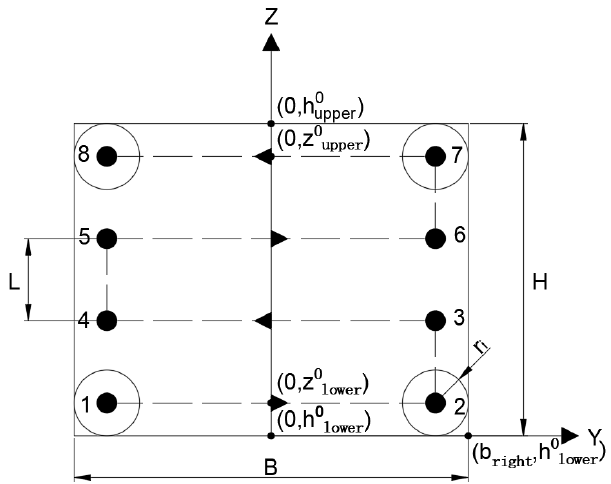
Figure 6. Inflection point diagram of the “snake” cutting path of a rectangular roadway.